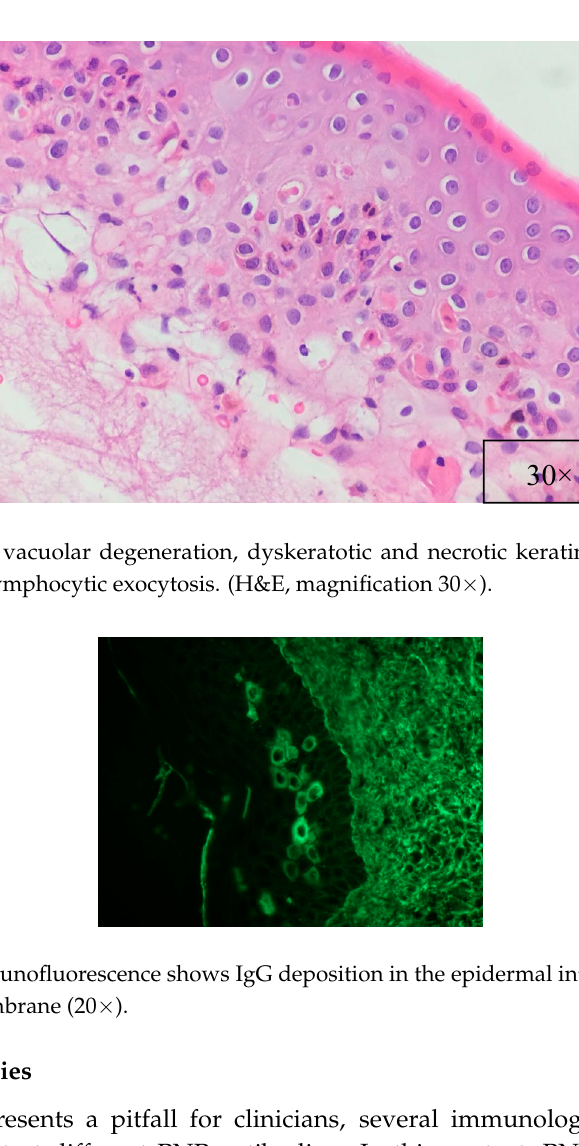
Figure 7. Direct immunofluorescence shows IgG deposition in the epidermal intercellular spaces and in the basement membrane (20×).